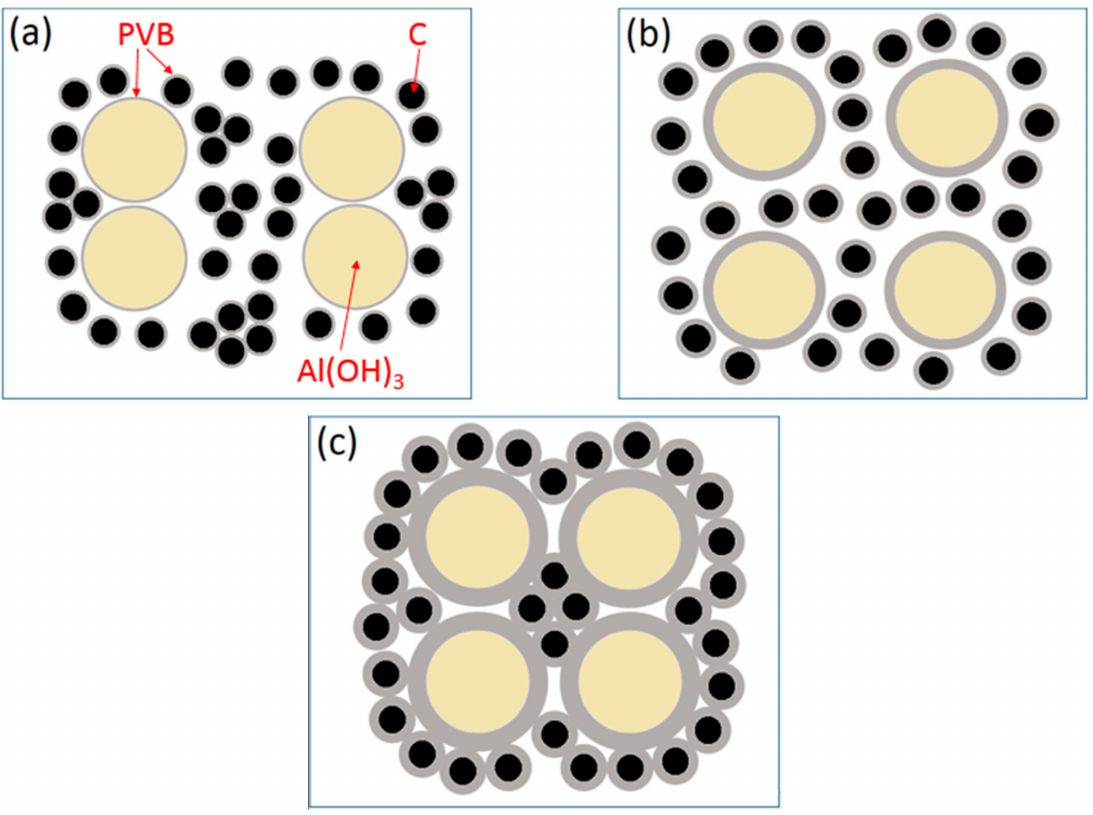
Figure 10. Sketch map of Al(OH) 3 /carbon black mixture covered with PVB layer: ( a ) thin PVB layer; ( b ) moderate PVB layer; and ( c ) thick PVB